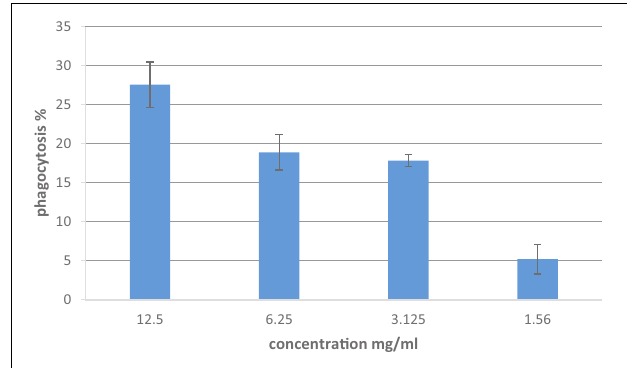
FIGURE 5 | In vitro phagocytic assay utilizing nitro blue tetrazolium (NBT) reduction test of peritoneal macrophage treated with different concentrations of lemon and ginger combination water extract for 48 h. Results are expressed as means of three independent experiments (bars) ± SEM (lines).